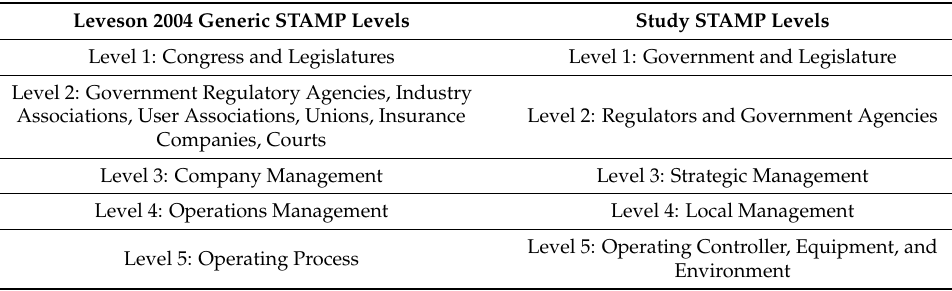
Table 1. Comparison of System Hierarchy